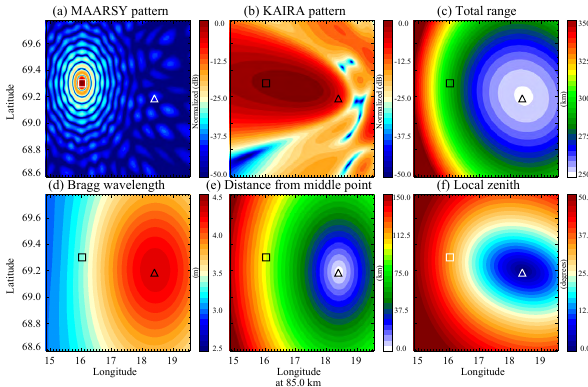
Figure 3. Antenna patterns and geometric parameters for the MAARSY–KAIRA multi-static configuration as a function of lon- gitude and latitude at 85km. (a) MAARSY one way transmitting pattern, (b) KAIRA narrow beam pointing over MAARSY, (c) total range, (d) Bragg wavelength, (e) distance with respect to the middle point, and (f) the resulting zenith angle with respect to local zenith. The locations of MAARSY and the middle point are indicated with a square and triangle symbols,